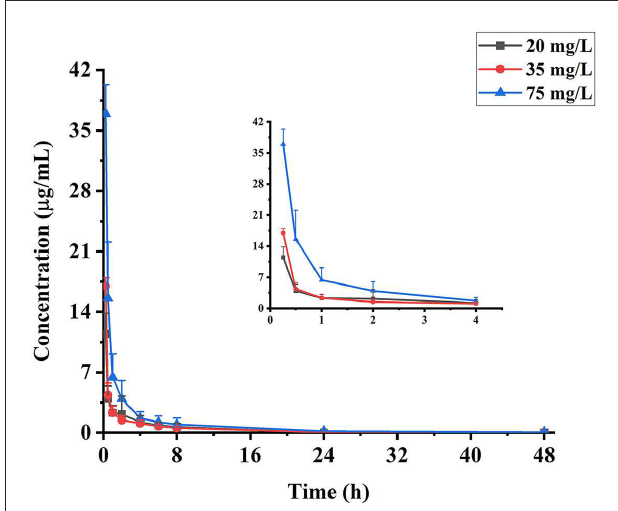
FIGURE2 Concentration-time curves of eugenol in carp plasma collected at 0.25, 0.5, 1, 2, 4, 6, 8, 24, and 48h ( n = 10), following medicated bath administration of 20, 35, and 75 mg/L of eugenol.